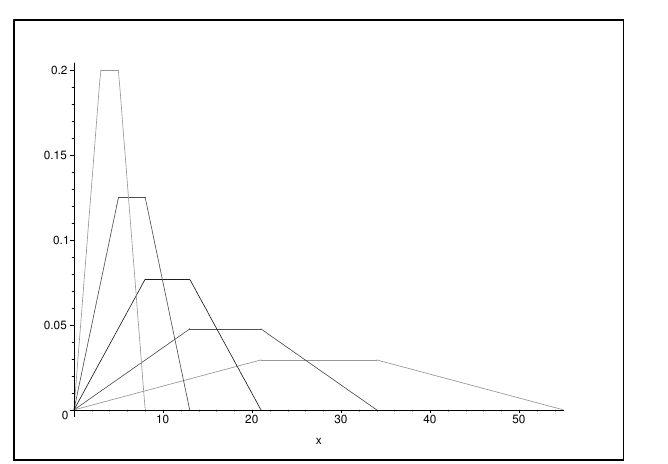
( x ) , n = 5,6,7,8,9, given in X n